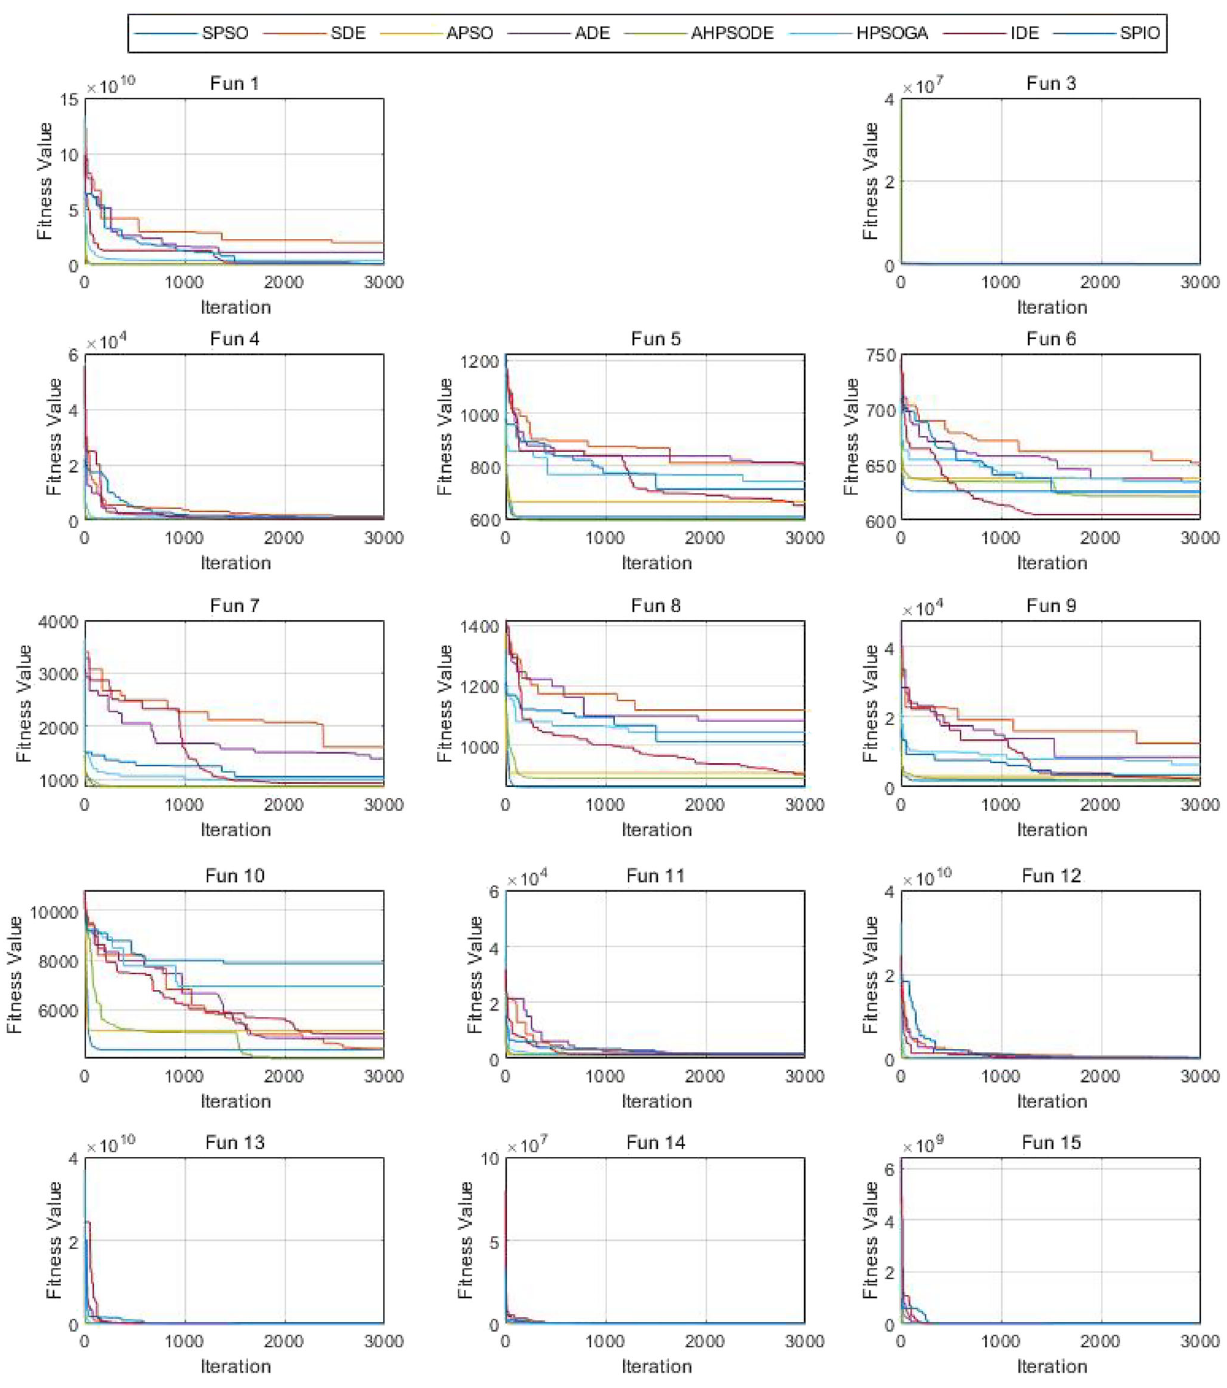
Fig. 23 Convergence curve of different algorithms on CEC 2017 at 30-D (Fun